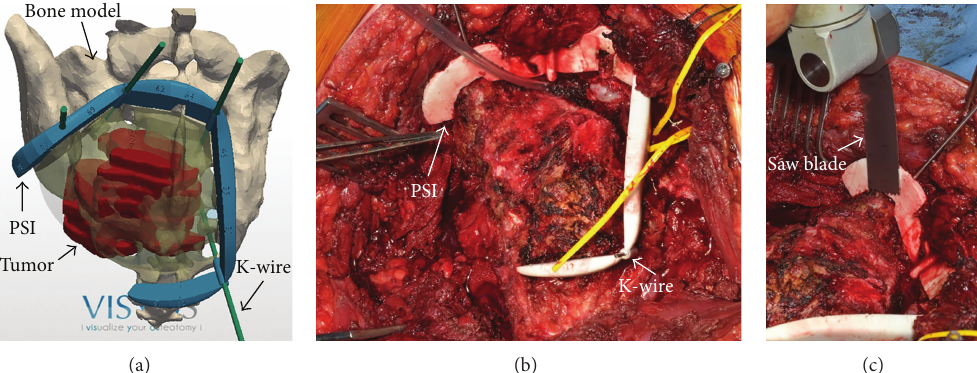
Figure 3: Intraoperative situation for patient number 11. (a) PSI is designed using computer-aided-design software. (b) PSI are sterilizable to be manipulated by the surgeon in the operating room. PSI is positioned on the bone and temporarily fixed using Kirschner wires. (c) Cuts are initiated with the oscillating saw guided by the flat surfaces of the